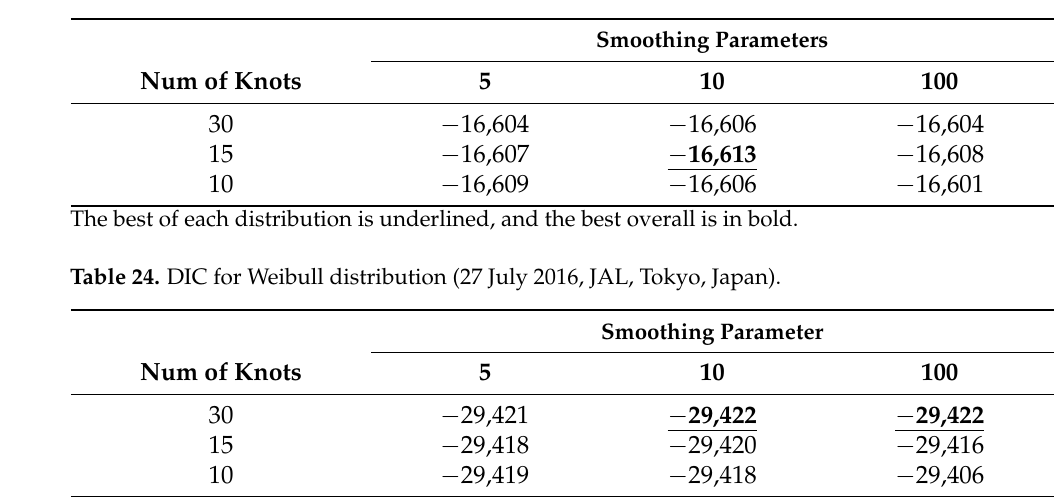
Smoothing Parameter